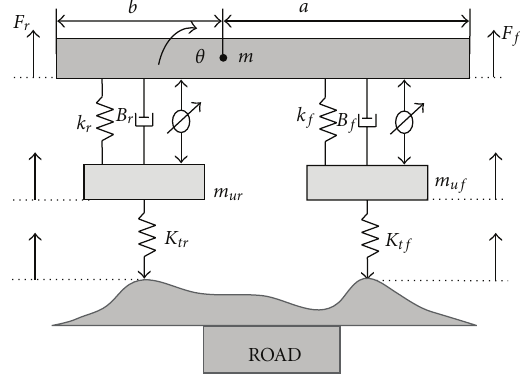
Figure 3: Half-car suspension